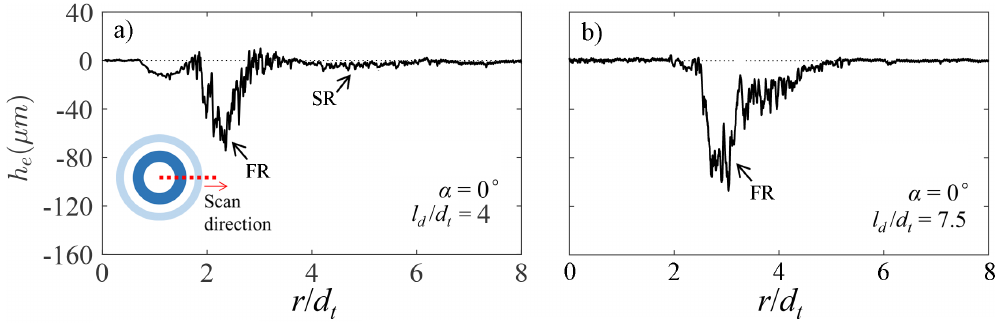
Figure 5. Profiles of the erosion at α = 0 ◦ : ( a ) l d / d t =4 and ( b ) l d / d t =